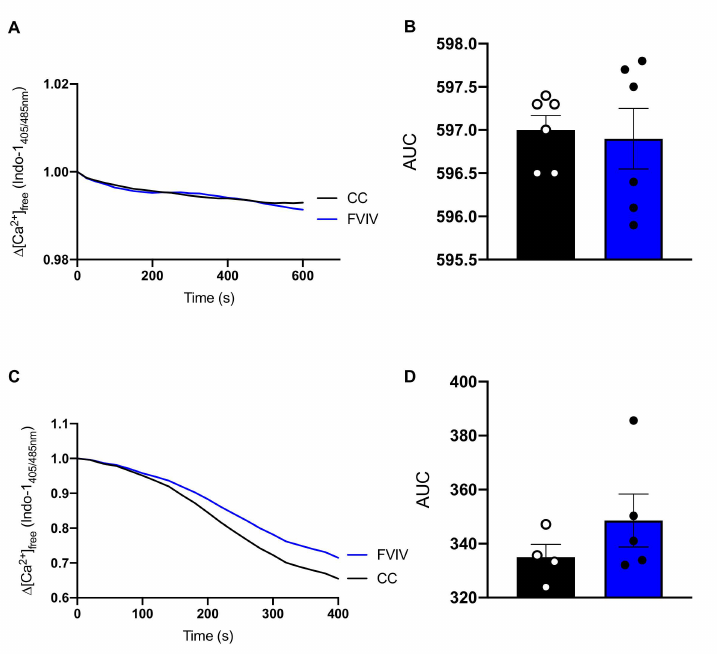
Figure A1. Ca 2+ uptake assays in cohort control 1 and 2 (CC1 and CC2) from soleus ( A , B ) and TA ( C , D ) muscles. Area under the curve analyses revealed no differences between CC1 and CC2 for soleus or TA. All values are means ±